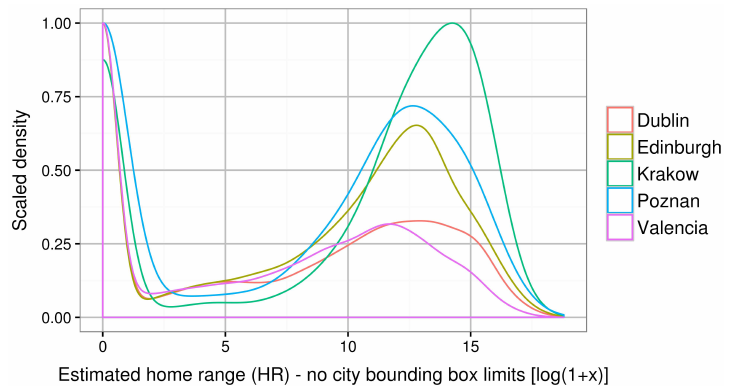
Figure 3. Estimated home range of users in selected cities. Based on D2 dataset—see explanation in